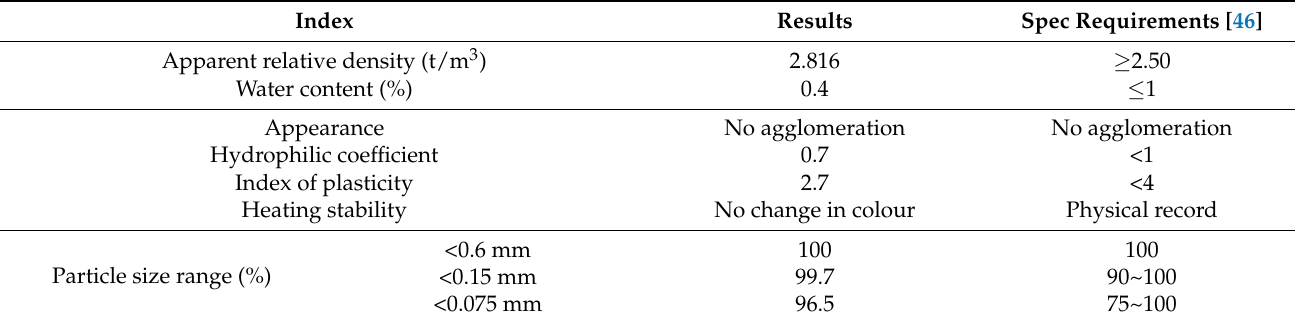
Table 4. Technical indices of the filler.